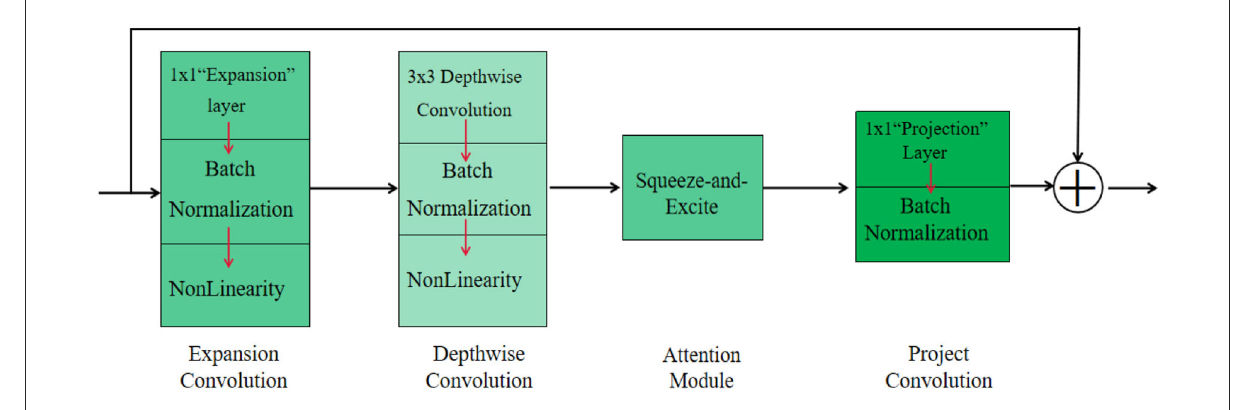
FIGURE3 Overall structure of MobileNetv3 network.